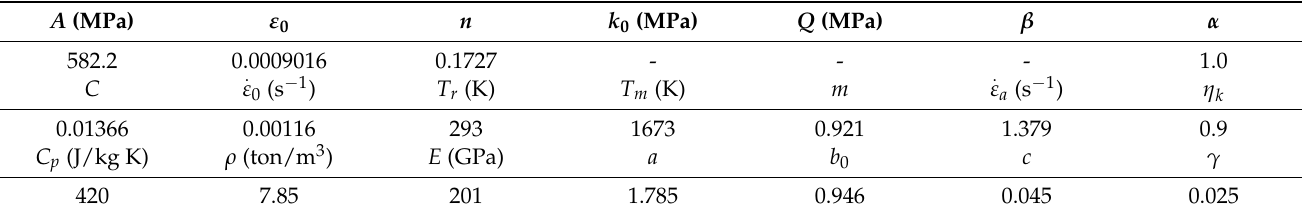
Table 1. Material model parameters used in panel penetration simulations.